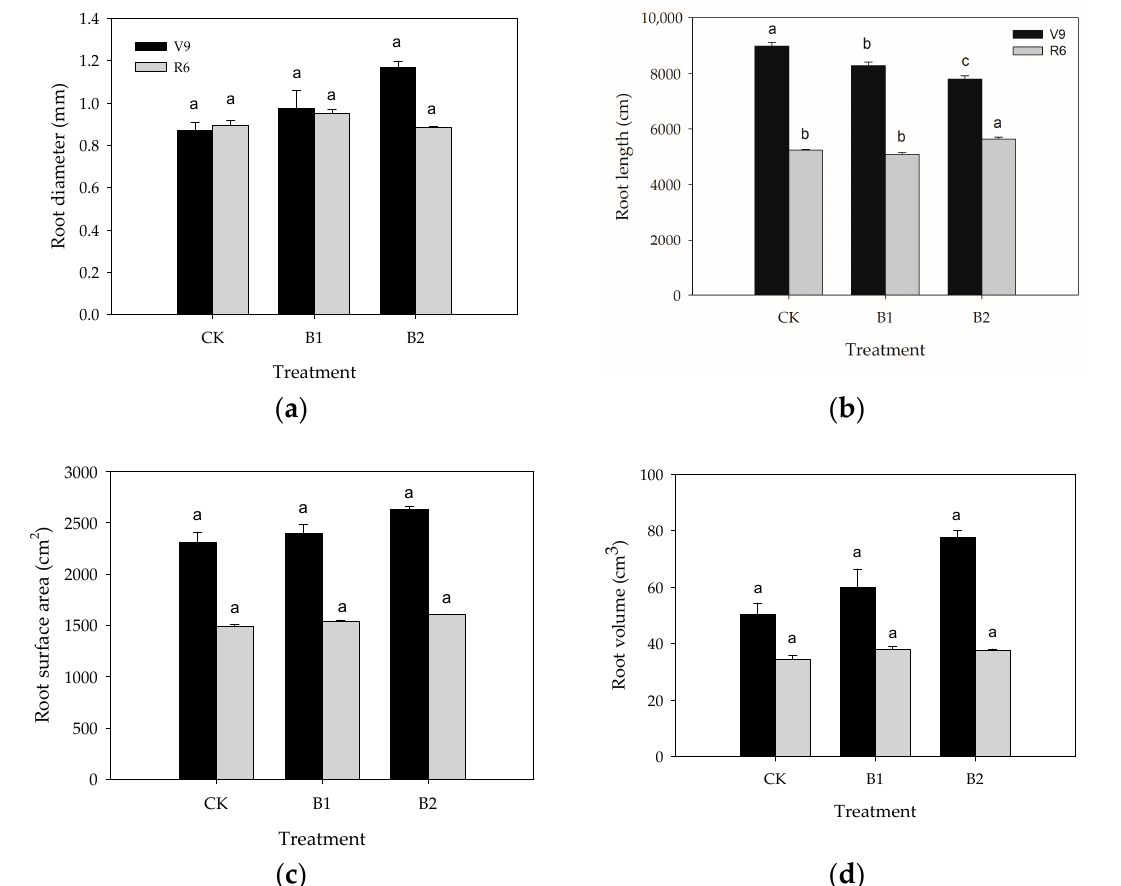
Figure 2. Root morphological characteristics of maize altered by biochar treatments. CK, conventional nitrogen fertilization; B1, application of 8.4 t ha − 1 biochar plus 225 kg ha − 1 nitrogen fertilizer; and B2, application of 21 t ha − 1 biochar plus 225 kg ha − 1 nitrogen fertilizer. ( a ) Root diameter; ( b ) Root length; ( c ) Root surface area; ( d ) Root volume. Data are mean ± SE ( n = 3). Different letters above the error bars indicate significant differences between treatment groups at p < 0.05.